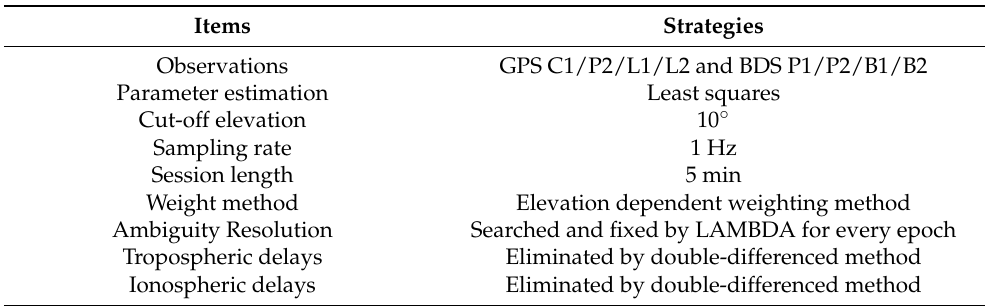
Table 1. GNSS data processing strategies.